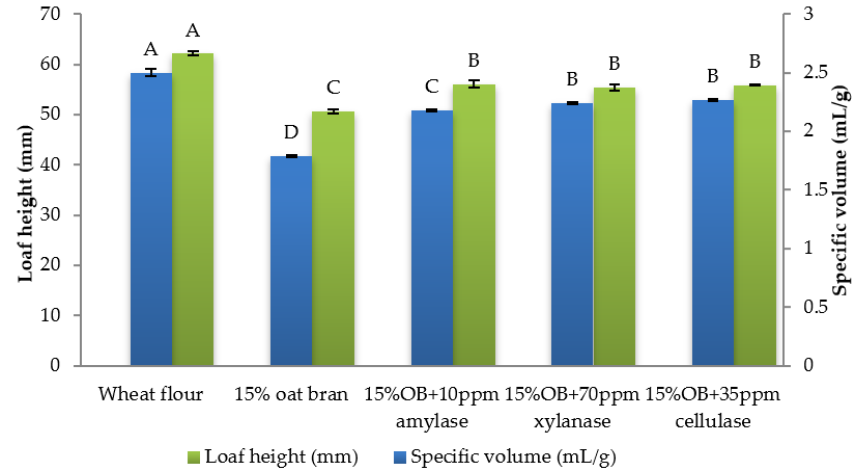
Figure 1. Specific volume and loaf height of Chinese steamed bread with single enzyme. Values with different letters differ significantly ( p < 0.05).